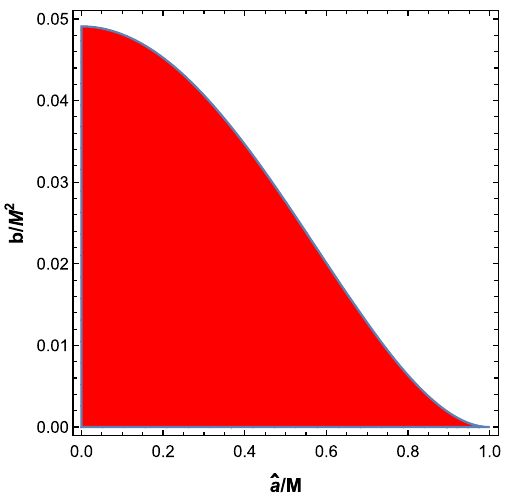
Fig. 3 It is the parameter space ( ˆ a / M − b / M 2 ) . The colored regions correspond to parameter space for which we have a black